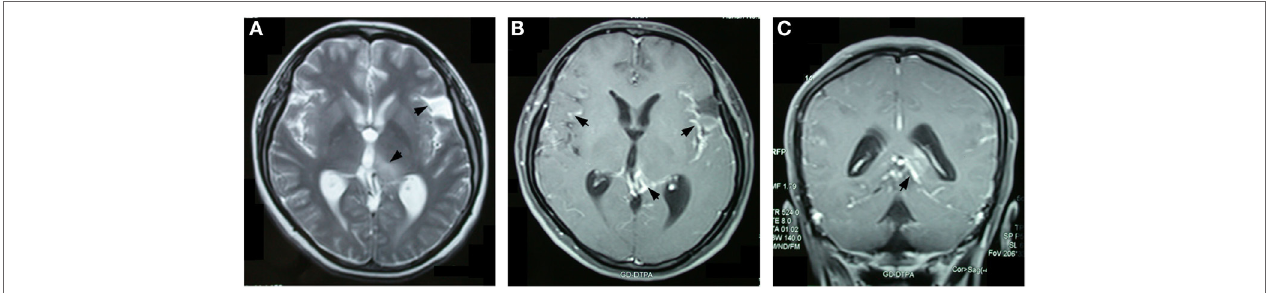
FIGURe 1 | Brain magnetic resonance imaging 2 months after the onset of symptoms revealed an abnormal signal with hyper-density on T2-weighted images in the left thalamus and the dilated left Sylvian fissure (a) . Overall enhancement was present in the cerebral meningeal, the cerebellar tentorium, the pia mater around left the thalamus, and the quadrigeminal cistern, but not in the left thalamus (B,C)